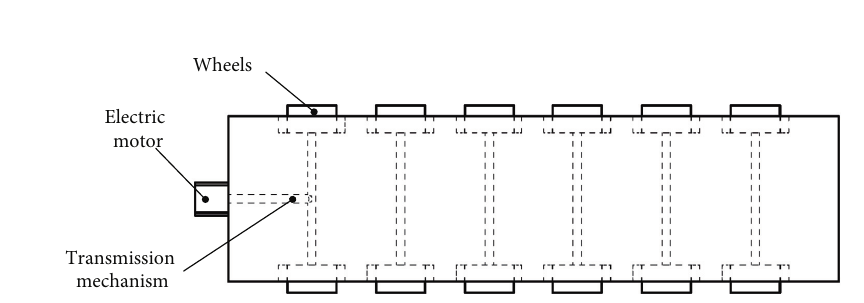
Table 1: Correspondence between condition separation principle and invention principle. Separation upon condition